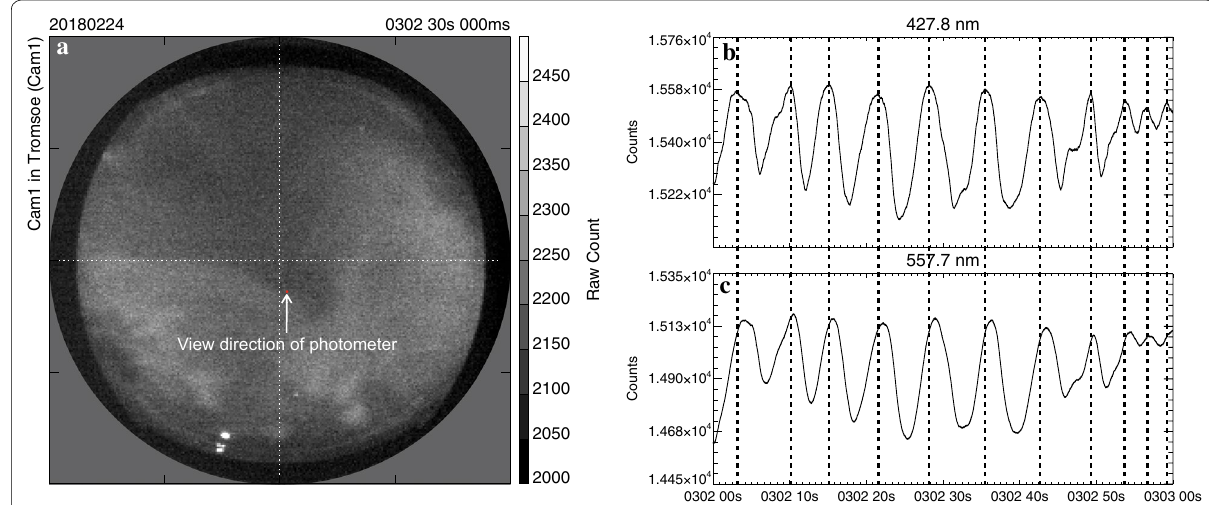
Fig. 1 a An image recorded by the EMCCD all‑sky camera in Tromsø at 03:02:30 UT on 24 February 2018. The red circle indicates the field‑of‑view of the five‑wavelength photometer. Time‑series of auroral emissions at b 427.8 nm, and c 557.7 nm obtained from the five‑wavelength photometer for a 1‑min interval from 03:02 UT to 03:03 UT on the same